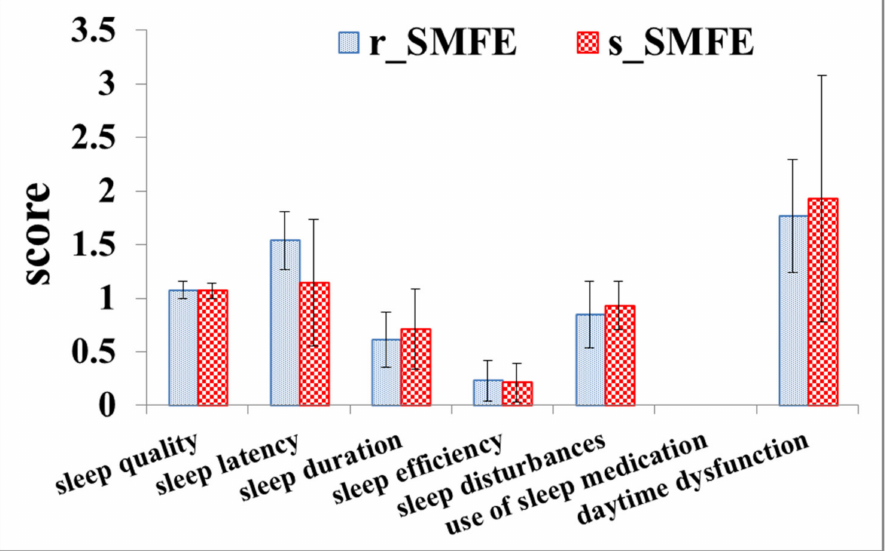
Figure 8. PSQI result. The error bars represent the standard deviation.